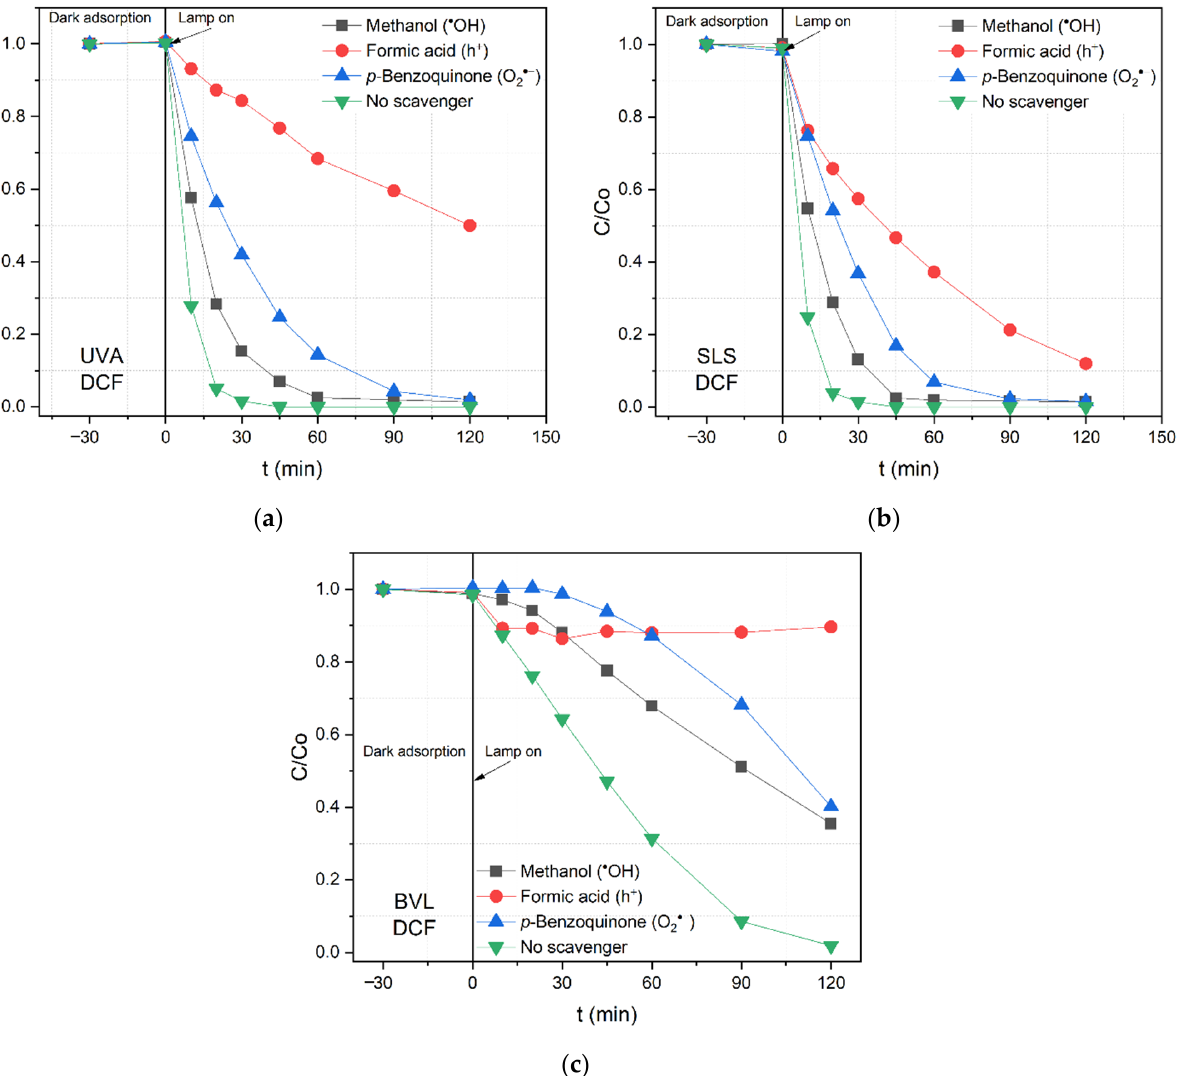
Figure 7. Photocatalytic degradation of diclofenac (DCF) by N/TiO 2 /rGO with 0.25 wt.% of rGO material in the presence of different scavenger agents under ( a ) UVA light, ( b ) solar light simulator (SLS), and ( c ) blue visible light (BVL).